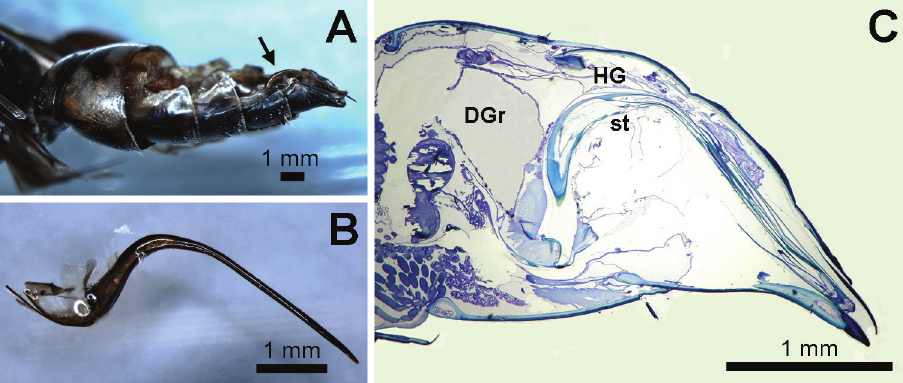
Figure 4. A Partially dissected gaster of a collection specimen of Myzinum sp.1, showing the dorsally curved sting (arrow) B Overview of sting ( Myzinum sp.1) C Longitudinal semithin section through the posterior abdomen part of Myzinum sp.2 female, showing upward curved sting (st). DGr: Dufour gland reservoir, HG: